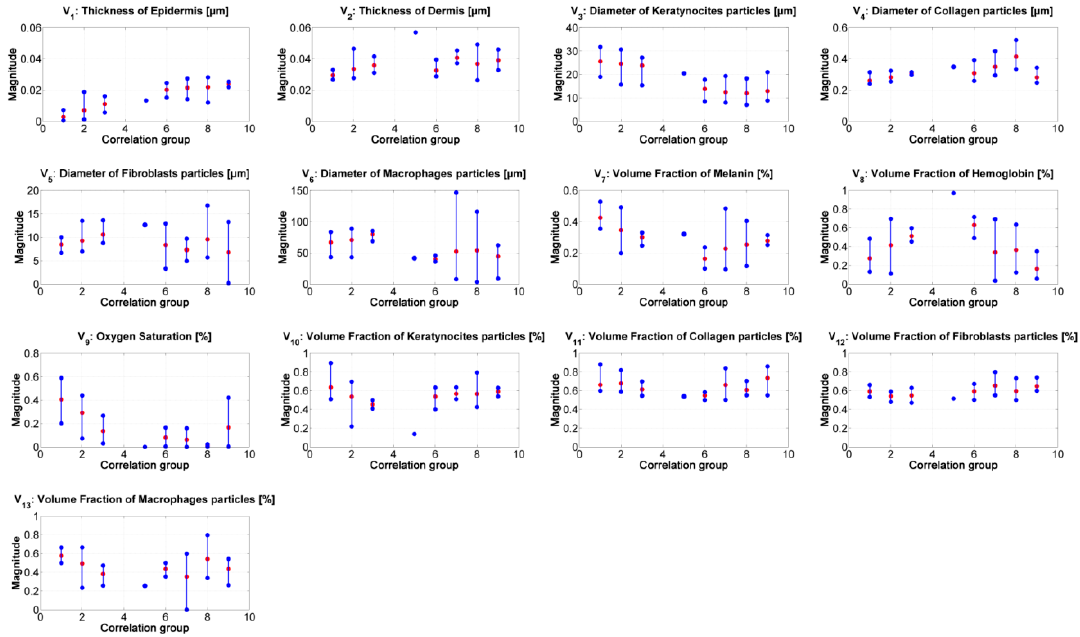
Figure 7. Results of the inverse modeling procedure. The results correspond to the median value obtained from the inverse model’s results obtained from the spectra belonging to the corresponding correlation-coefficient group. Red dots: median value of the corresponding samples in the group. Blue points: minimum and maximum values of the group’s results.